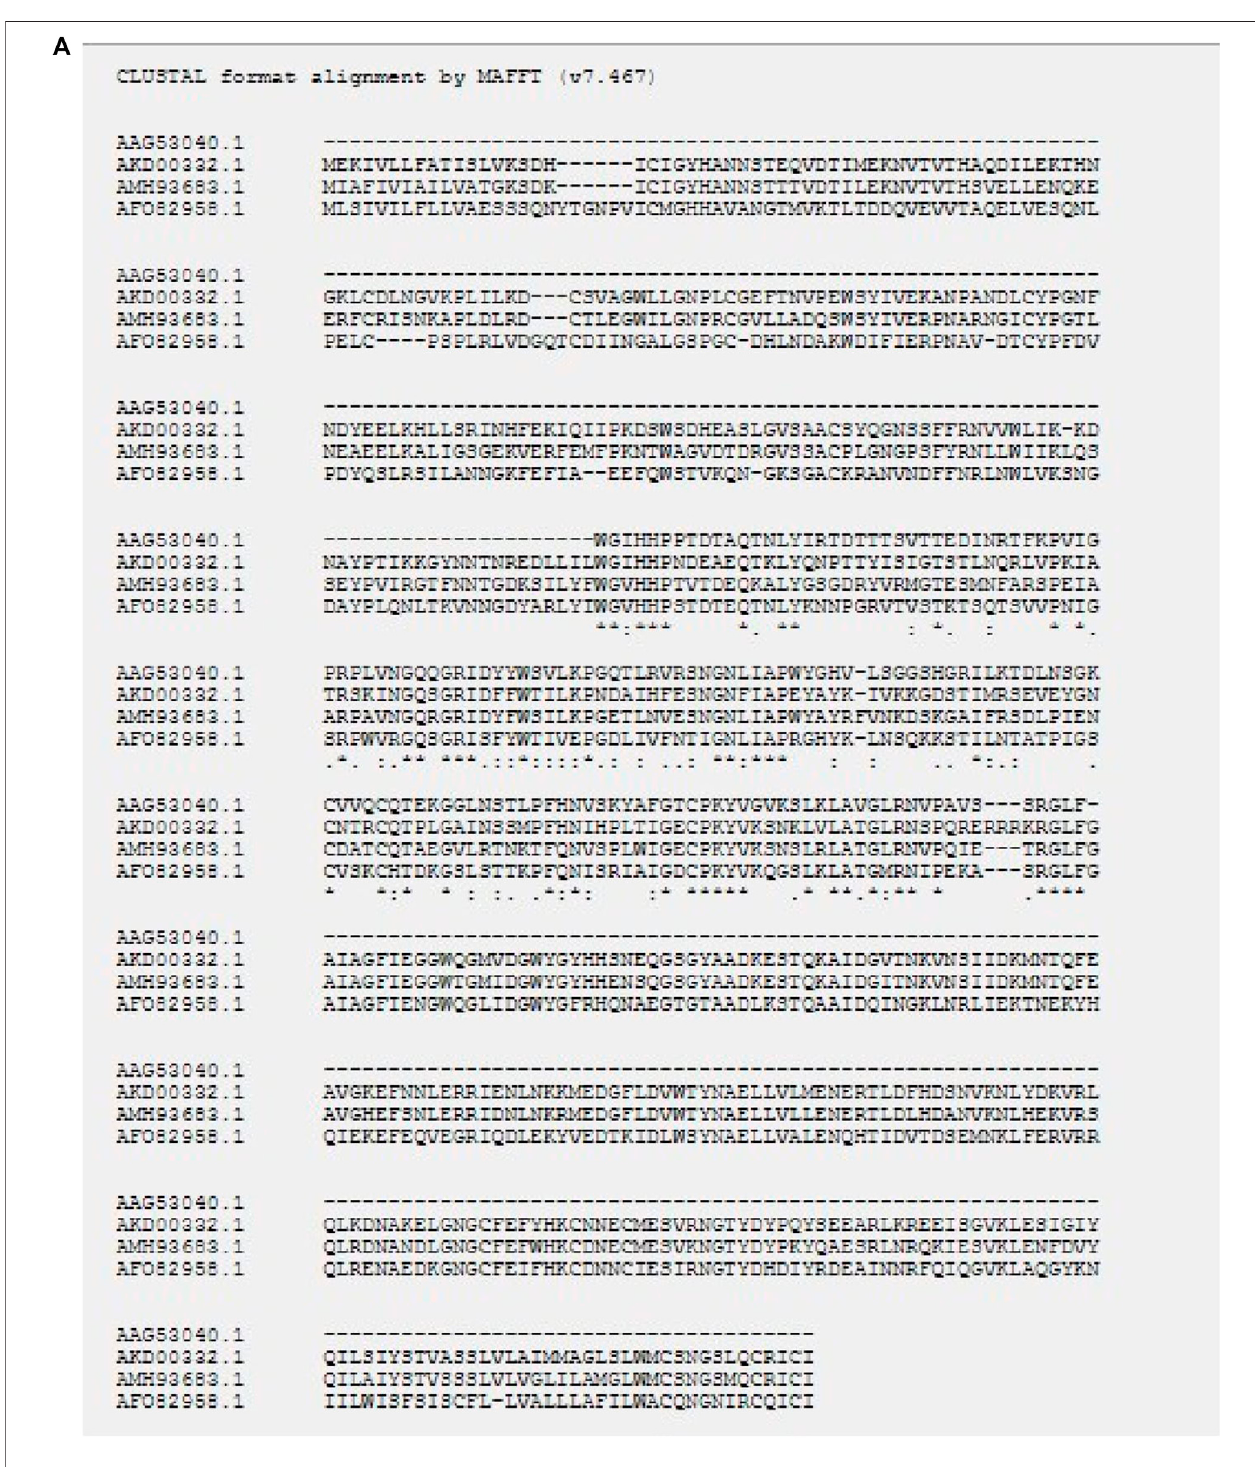
FIGURE 8 | (A) Alignment report for Haemagglutinin antigen for different strains for Avian in fl uenza (B) Alignment report for Haemagglutinin antigen for different strainsforAvianin fl uenzabyMAFFTsoftware(MSAviewer) (C) AlignmentreportforneuraminidaseantigenfordifferentstrainsforAvianin fl uenza (D) Alignmentreportfor neuraminidase antigen for different strains for Avian in fl uenza by MAFFT software (MSA viewer).